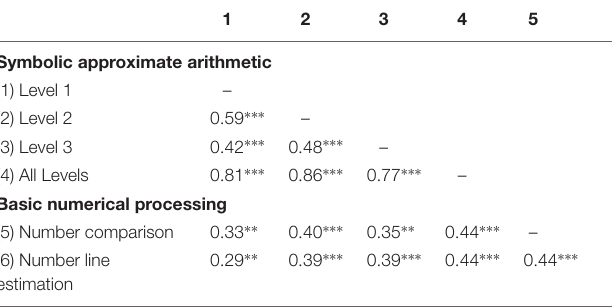
TABLE 2 | Correlations between the basic numerical magnitude processing tasks and different difficulty levels of the symbolic approximate arithmetic tasks after controlling for gender and